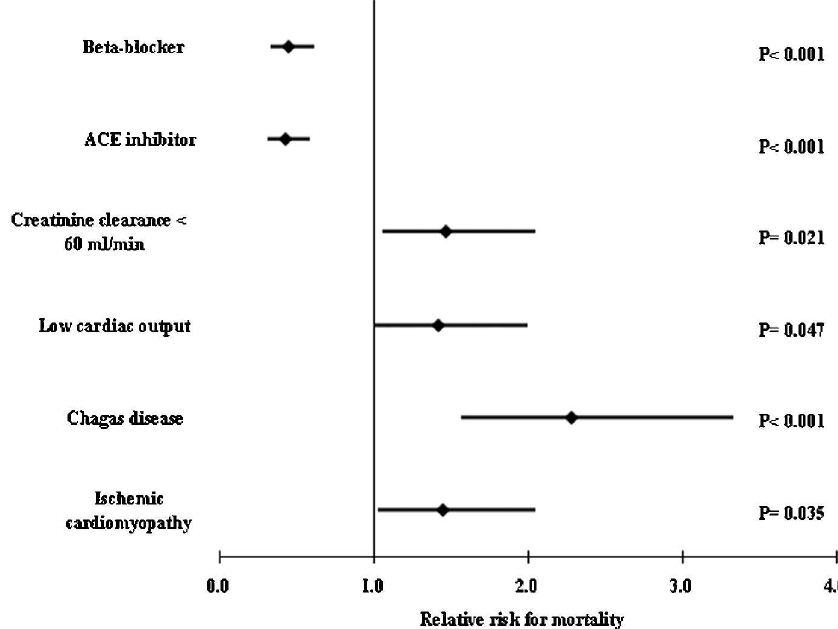
Figure 2 - Predictors of all-cause